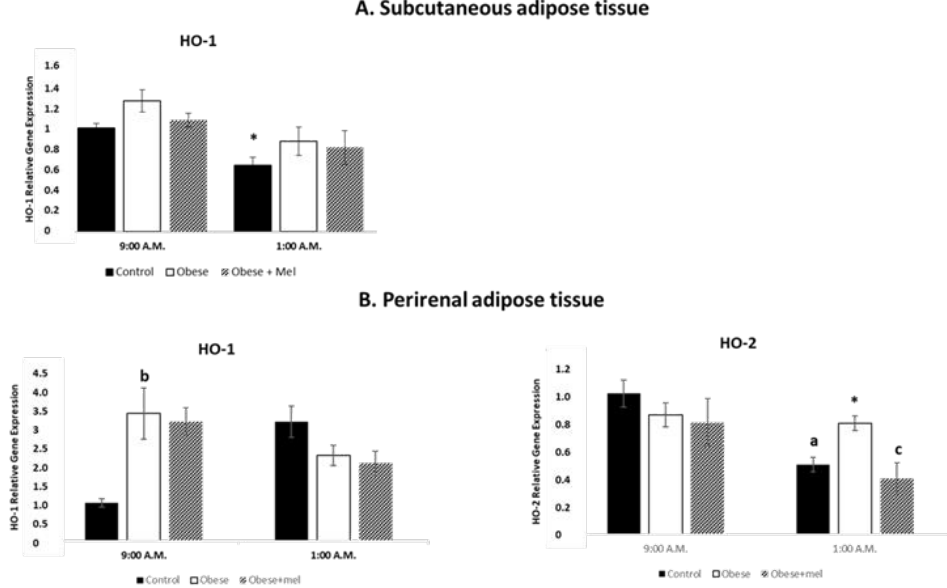
Figure 1. Relative gene expression of HO1 enzyme in subcutaneous ( A ) and perirenal ( B ) adipose tissue and HO2 in perirenal adipose tissue of male Wistar rats at two different times (9:00 a.m. and 1:00 a.m.). Each value represents the mean and s.e.m. (n = 5). The letter indicates significant differences between diets (control or high fat diet) at the same schedule ( a p < 0.05 vs. control; b p < 0.001 vs. control group of animals; c p < 0.05 vs. obese group of animals) and the asterisk (* p < 0.05) indicates significant differences between schedules in each experimental group.